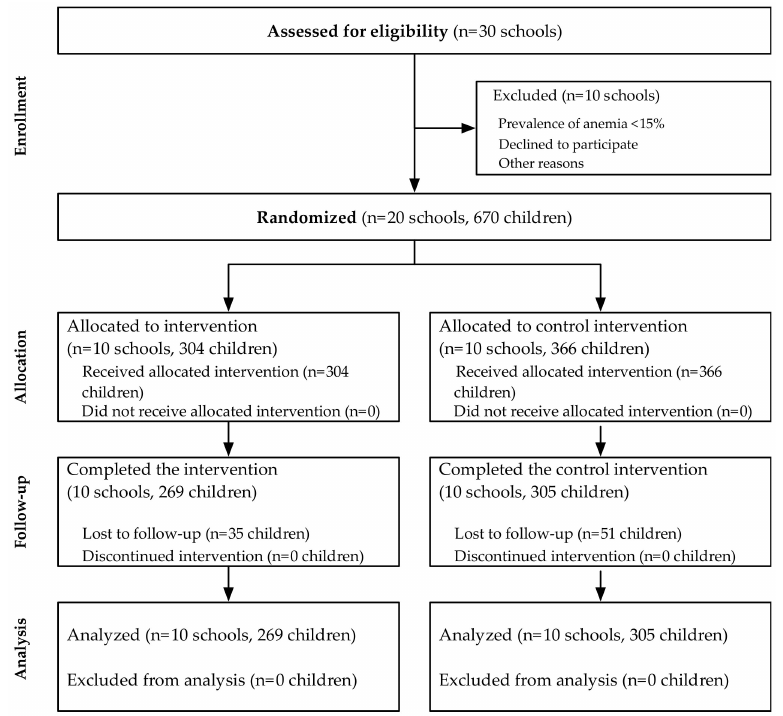
Figure 1. CONSORT Diagram for Cluster-Randomized